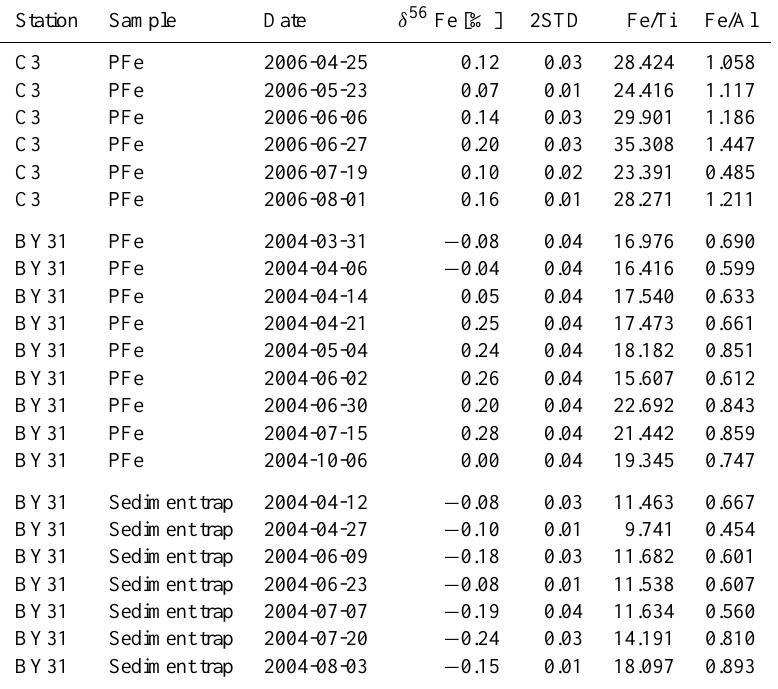
Table 4. Fe isotopic composition ( δ 56 Fe) of suspended matter (PFe) at 5m depth at C3 (Bothnian Sea) and BY31 (Landsort Deep, Baltic Proper) and sediment trap collected material at BY31. “2STD” denote instrumental precision ± 2 STD of the mean. Fe/Ti and Fe/Al denote the ratios between these elements in the samples